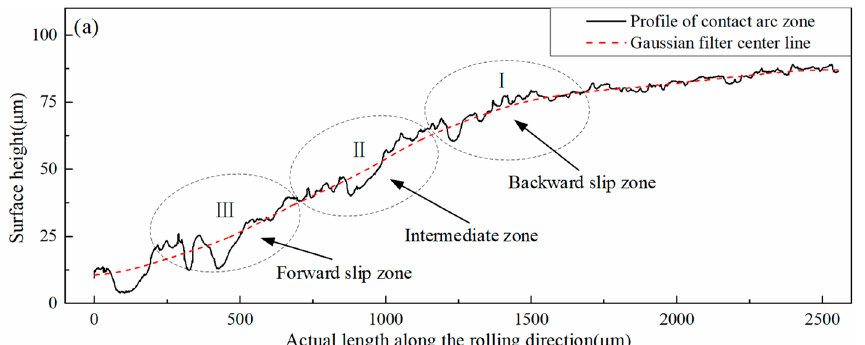
Figure 7. Cont Ⅱ